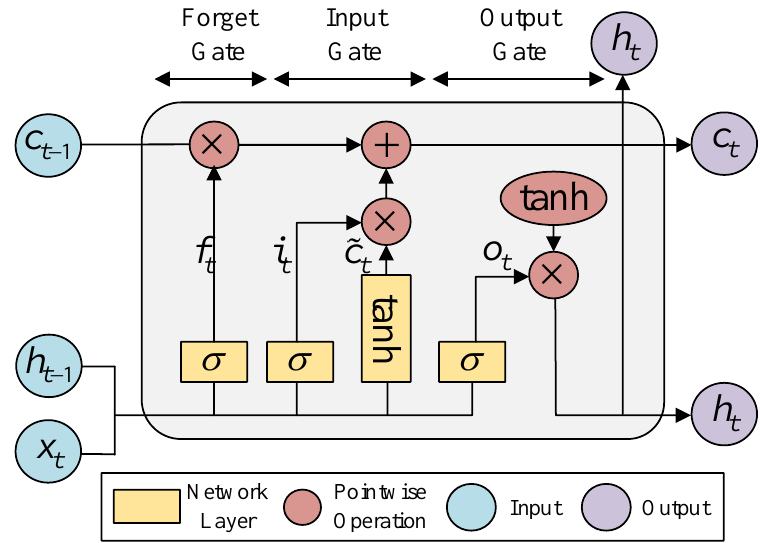
Figure 3. Representation of LSTM cell.